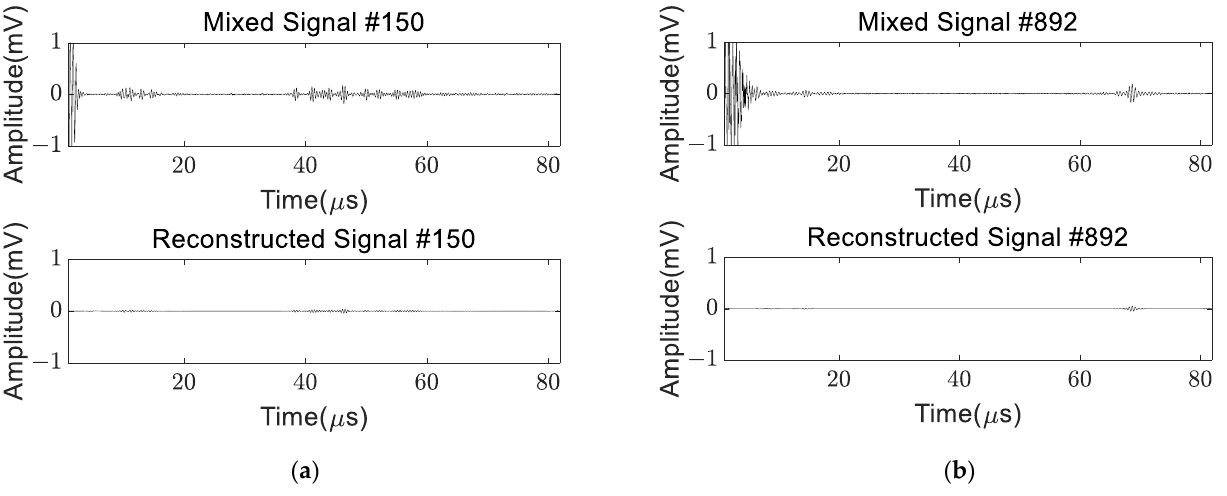
Figure 11. The examples of signals that are not extracted properly: ( a ) A-scan mixed crack signal data and extracted crack signal from flaw #150; ( b ) A-scan mixed slag inclusion signal data and extracted slag inclusion signal from flaw #892.